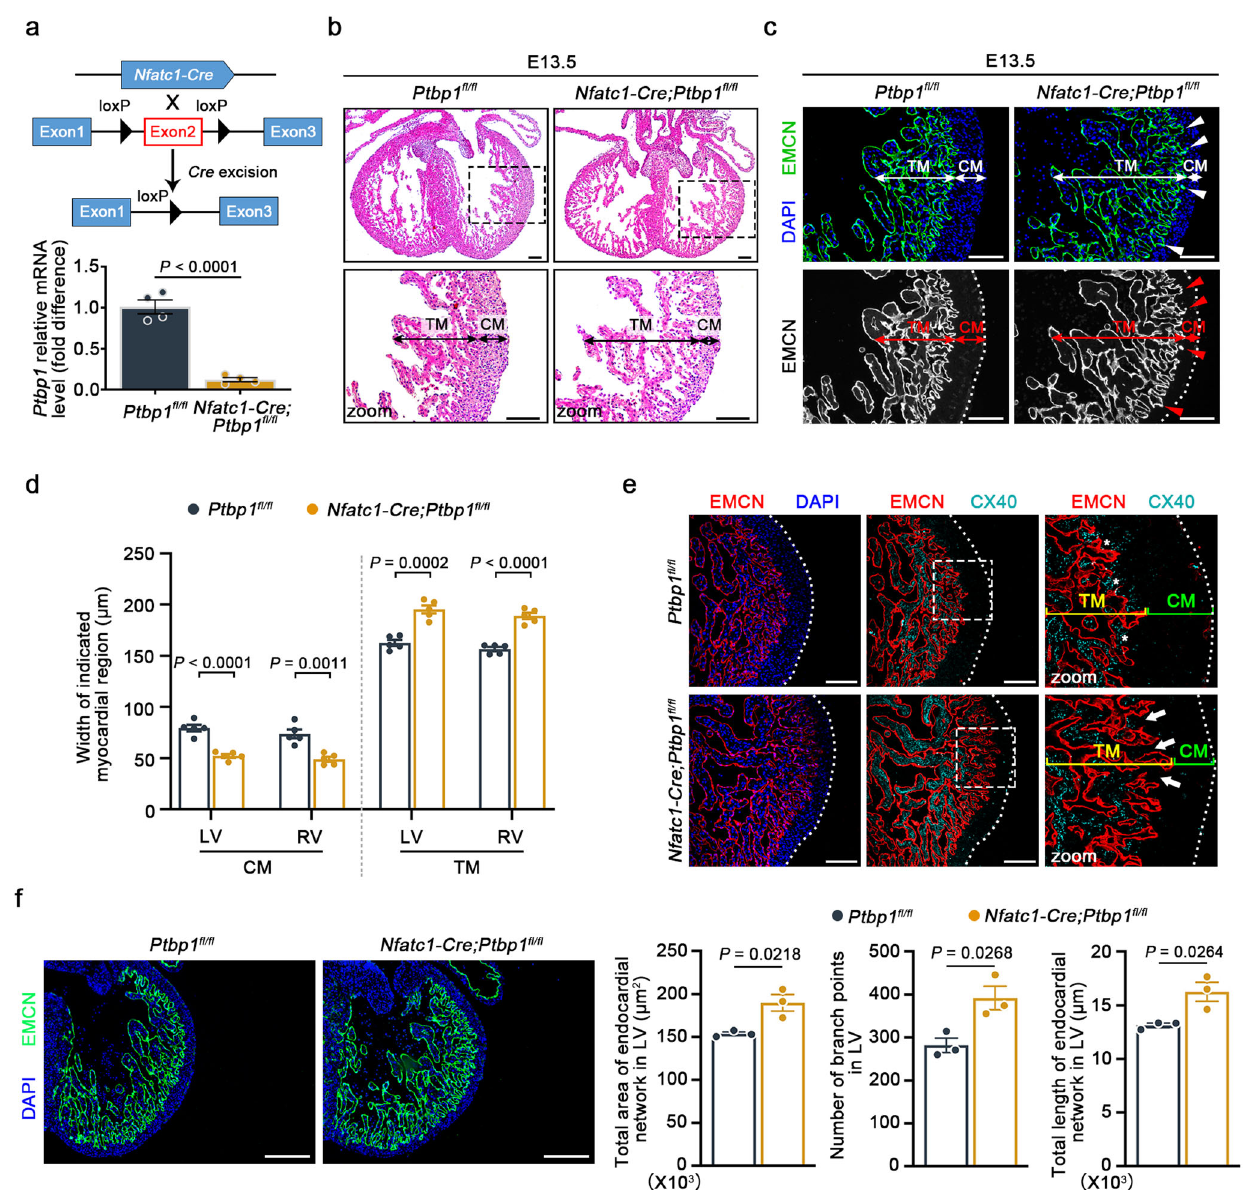
Fig. 2 | Endocardial-speci fi c knockout of Ptbp1 leads to ventricular non- compaction. a Generation of the Ptbp1 endocardial-speci fi c knockout ( Nfatc1- Cre ; Ptbp1 fl / fl ) mouse line. Top: schematic diagram showing the generation of the Nfatc1-Cre ; Ptbp1 fl / fl mouse line. Bottom: qRT-PCR examination of the Ptbp1 mRNA level in endothelial cells isolated from E13.5 Ptbp1 fl / fl and Nfatc1-Cre ; Ptbp1 fl / fl hearts. n =4micepergroup. b H&Estainingshowingthetrabecularmyocardium(TM)and compact myocardium (CM) in E13.5 Ptbp1 fl / fl and Nfatc1-Cre ; Ptbp1 fl / fl heart tissue sections. Scale bars, 100 µ m. c , d Representative images and quanti fi cation of the TM and CM thickness in E13.5 Ptbp1 fl / fl and Nfatc1-Cre ; Ptbp1 fl / fl hearts. The graph showsthereducedthicknessoftheCMandincreasedthicknessoftheTMin Nfatc1- Cre ; Ptbp1 fl / fl hearts. n =5micepergroup.Thearrowheadsindicatetheexpressionof EMCN in the Nfatc1-Cre ; Ptbp1 fl / fl hearts. LV left ventricle, RV right ventricle. Scale